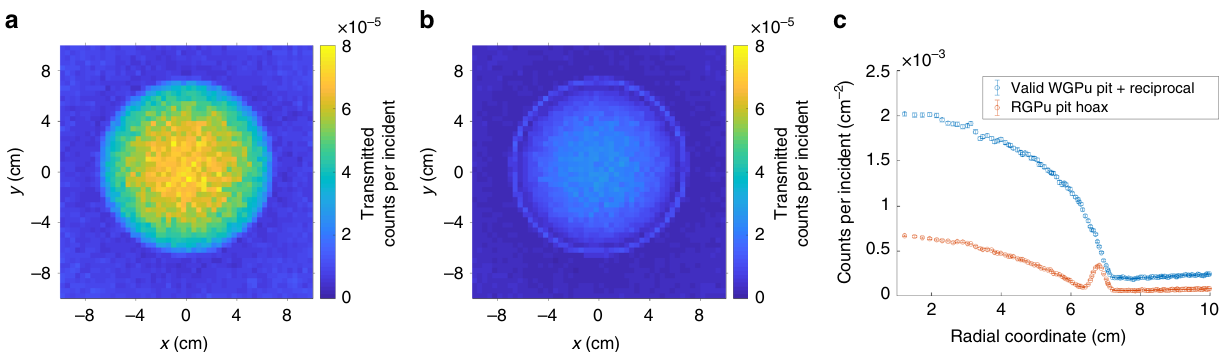
Fig. 4 Epithermal neutron images in the detector for two con fi gurations. a The valid WGPu-reciprocal scenario, b the RGPu-reciprocal hoax scenario, and c the radial distribution of the counts for both scenarios showing a clear discrepancy. The non- fl at image of the WGPu con fi guration is caused by the in- scatter of the epithermal neutrons. The error bars re fl ect one sigma standard deviations